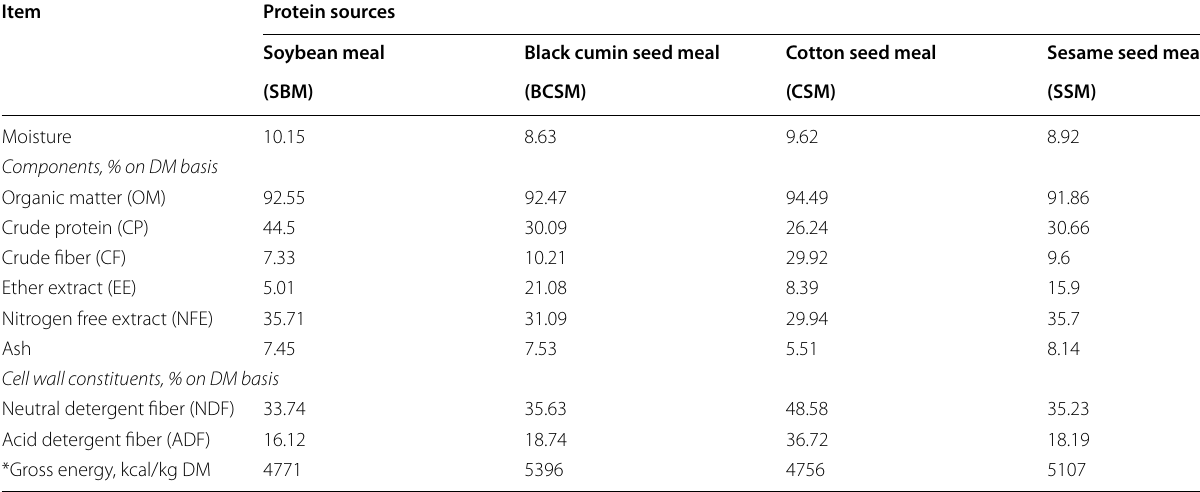
*Gross energy (kcal/kg DM) was calculated according to Blaxter (1968), where each g of C p